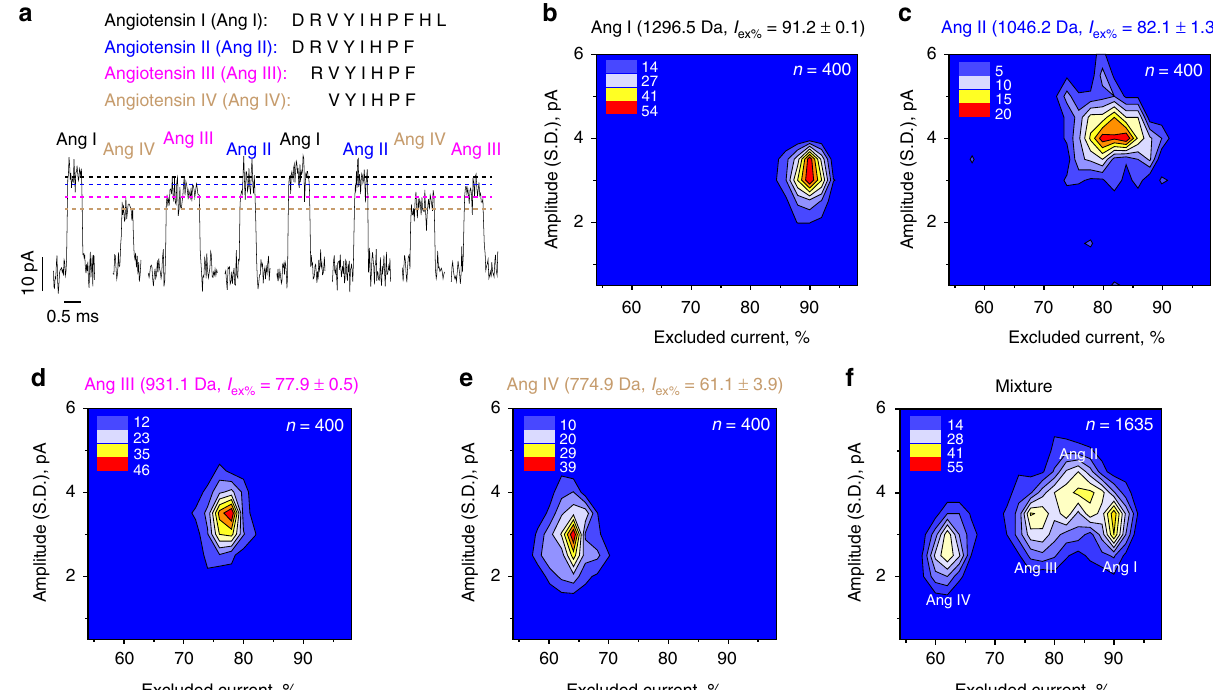
Fig. 2 Discrimination of angiotensin peptides using type II W116S-fragaceatoxin C (FraC) nanopores at pH 4.5. a Peptide sequences of angiotensin I (Ang I), angiotensin II (Ang II), angiotensin III (Ang III), and angiotensin IV (Ang IV) and typical blockades provoked by the four angiotensin peptides measured at − 30 mV. b – e Color density plot of the I ex% versus the standard deviation of the current amplitude for angiotensin I, II, III, and IV, respectively. f Discrimination of four angiotensin peptides in a mixture. Peptides were added into the cis chamber and measured at − 30 mV. Standard deviations were calculated from at least three independent repeats. Color density plots were created using